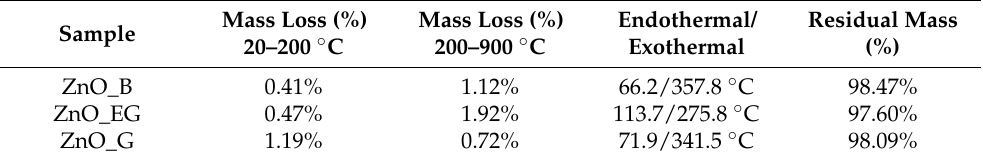
Table 1. The principal data from thermal